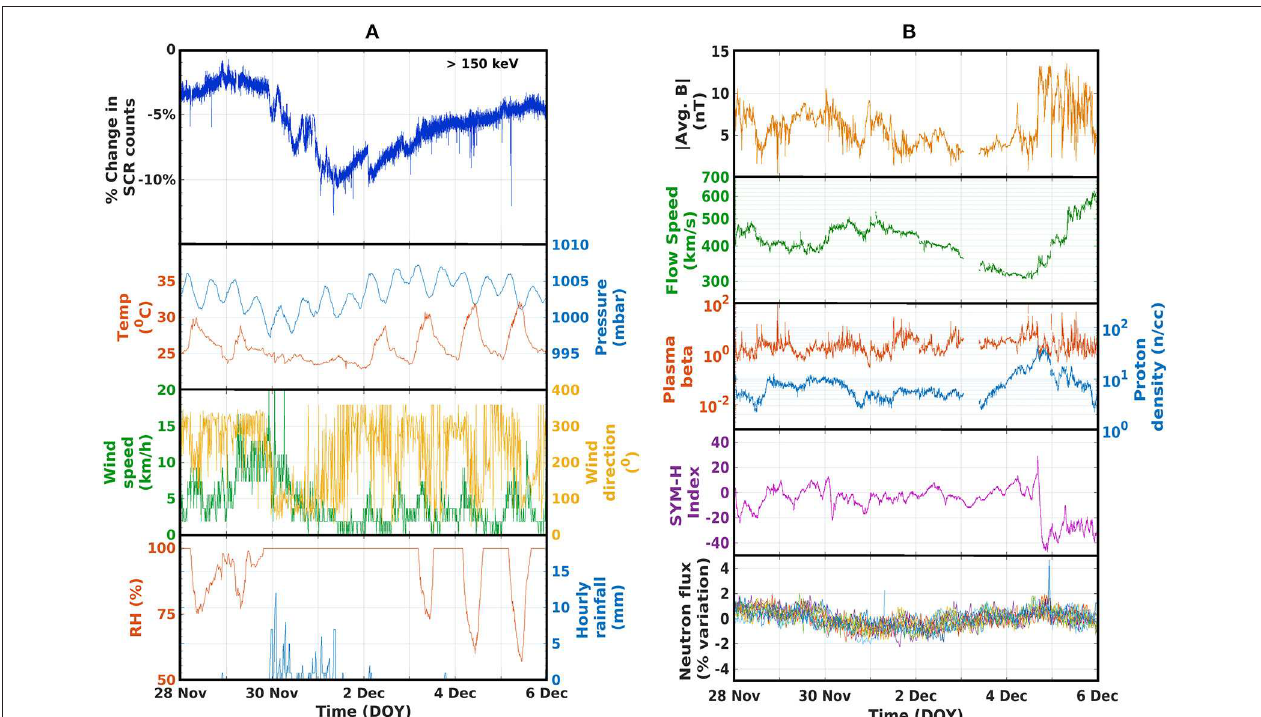
FIGURE 3 | (A) Percentage variations in γ -ray counts observed at Tirunelveli along with various atmospheric parameters; (B) Interplanetary and solar wind parameters, Sym-H index, ground observations from NM network.